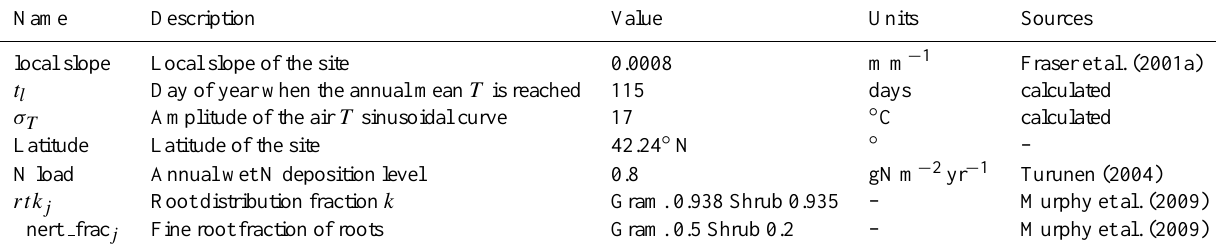
Table 2. Site-specific